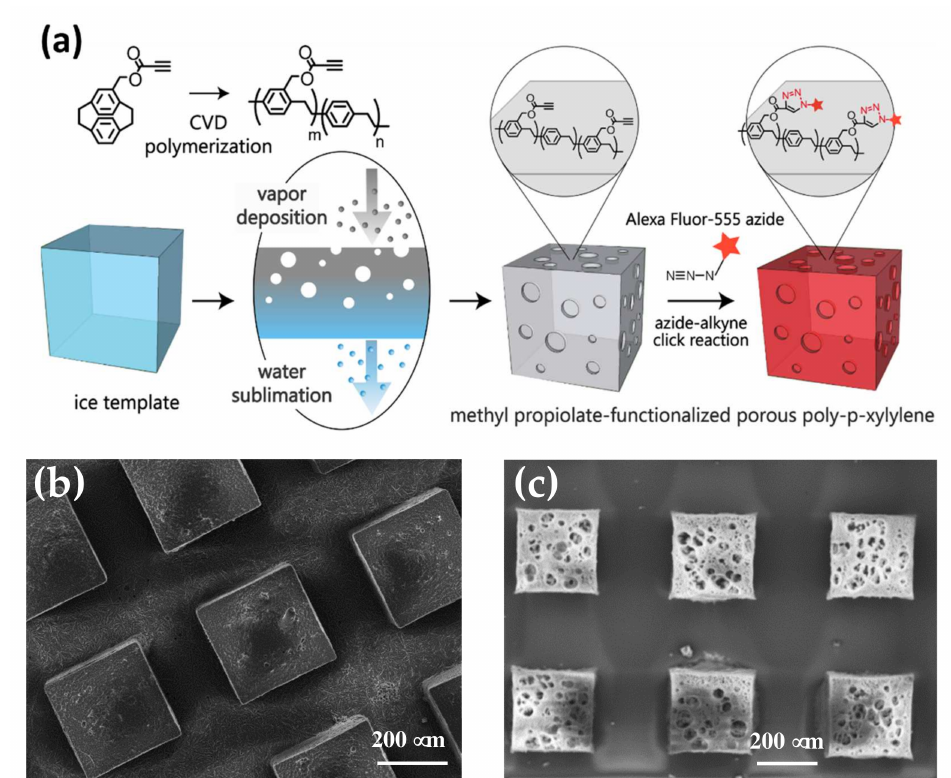
Figure 1. ( a ) Chemical vapor deposition (CVD) polymerization of methyl propiolate-substituted [2,2]-paracyclophane to form a poly((methyl propiolate- p -xylylene)- co -( p -xylylene)) porous structure and schematic illustration of vapor sublimation and deposition to fabricate a three-dimensional and porous structure that can undergo a copper-free click reaction with azide-terminated molecules. ( b ) SEM micrographs of the fabricated ice templates and ( c ) the resultant porous poly((methyl propiolate- p -xylylene)- co -( p -xylylene)) by the proposed fabrication process. An array structure composed of 300 µ m × 300 µ m × 300 µ m cubes was used in the study for